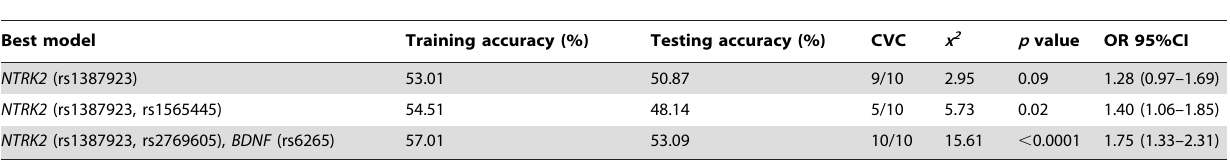
Table 4. The best model for predicting the occurrence of the paranoid schizophrenia.